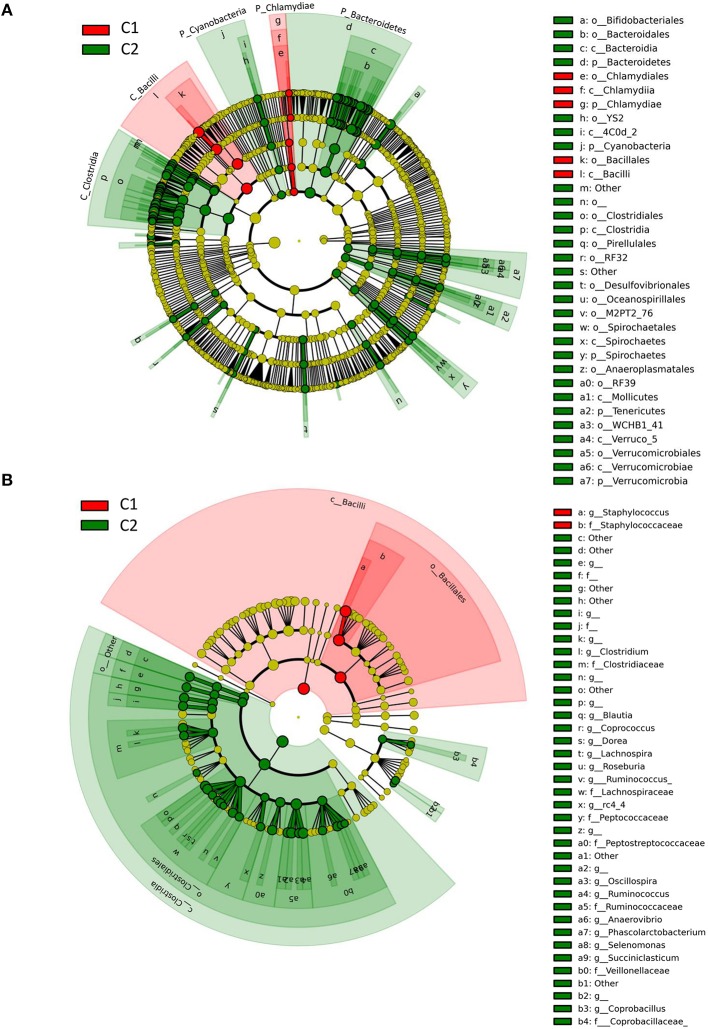
Taxonomic representation of differentially abundant taxa between Cluster 1 (contains quarters susceptible to mastitis) and Cluster 2 (contains healthy quarters), as determined by the LEfSe pipeline. Differences are represented by the color of the cluster where the taxon is more abundant (red indicates Cluster 1 and green indicates Cluster 2). The diameter of each circle is proportional to the abundance of the taxon. (A) Root of the cladogram refers to Bacteria. Only taxonomic levels L2 (phylum) to L4 (order) are labeled. See Table S5 for taxonomic level L5 (family) and L6 (genera). (B) Detailed composition of bacteria belonging to Bacilli and Clostridia classes shown in A (root of the cladogram refers to the phylum Firmicutes).